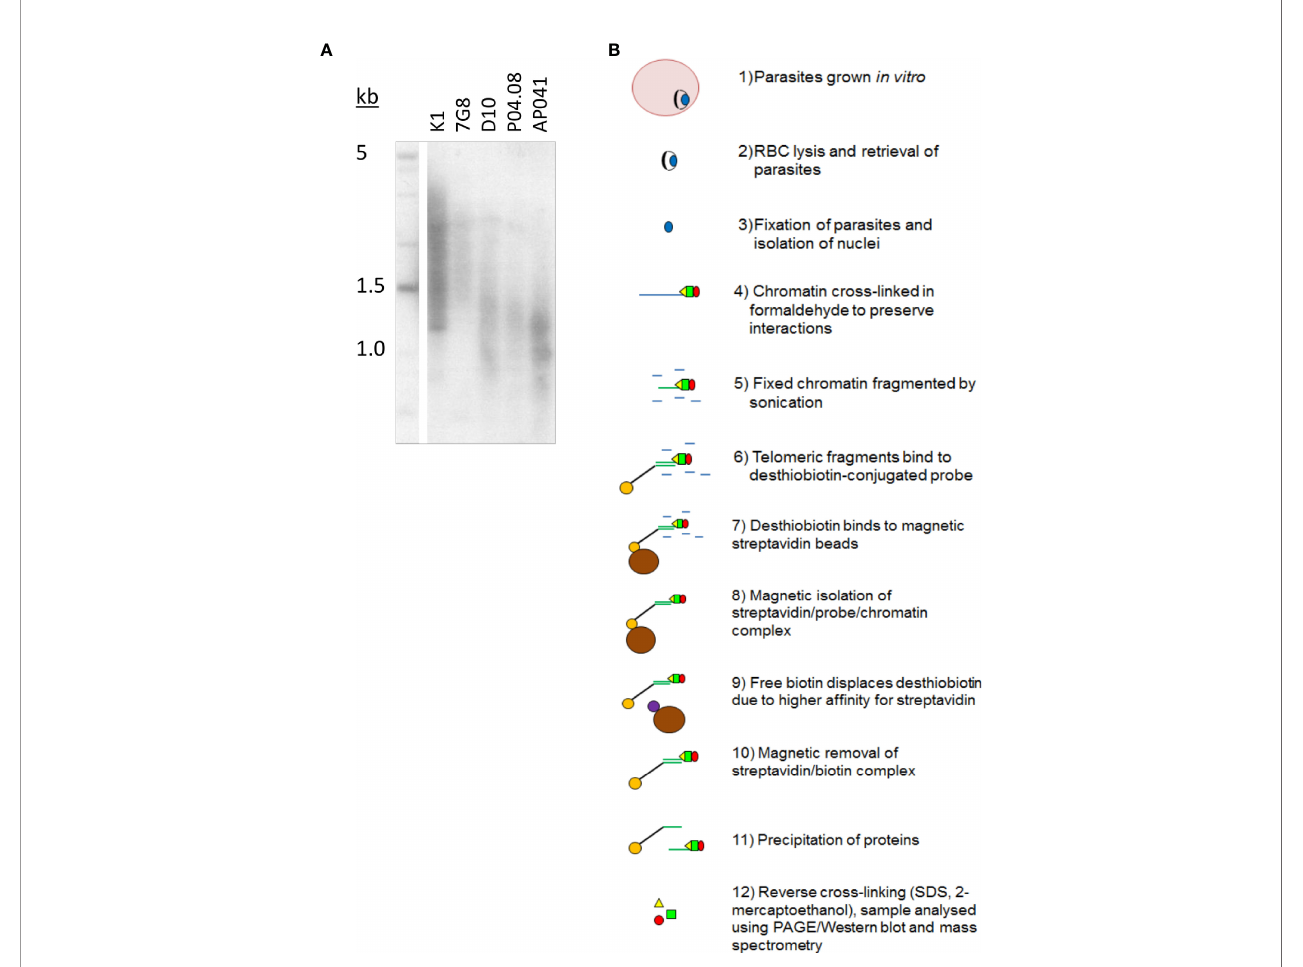
FIGURE 1 | Plasmodium telomeres vary in their set-point lengths. (A) Telomere Restriction Fragment Southern blot showing variation in telomere lengths in geographically diverse strains of P. falciparum (K1, Thailand; 7G8, Brazil; D10, Papua New Guinea; P04.08, Senegal; AP041, Nigeria). (B) Schematic showing the process of PICh in P. falciparum